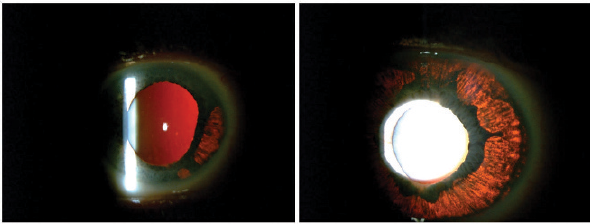
Figure 2 - Bilateral iris depigmentation